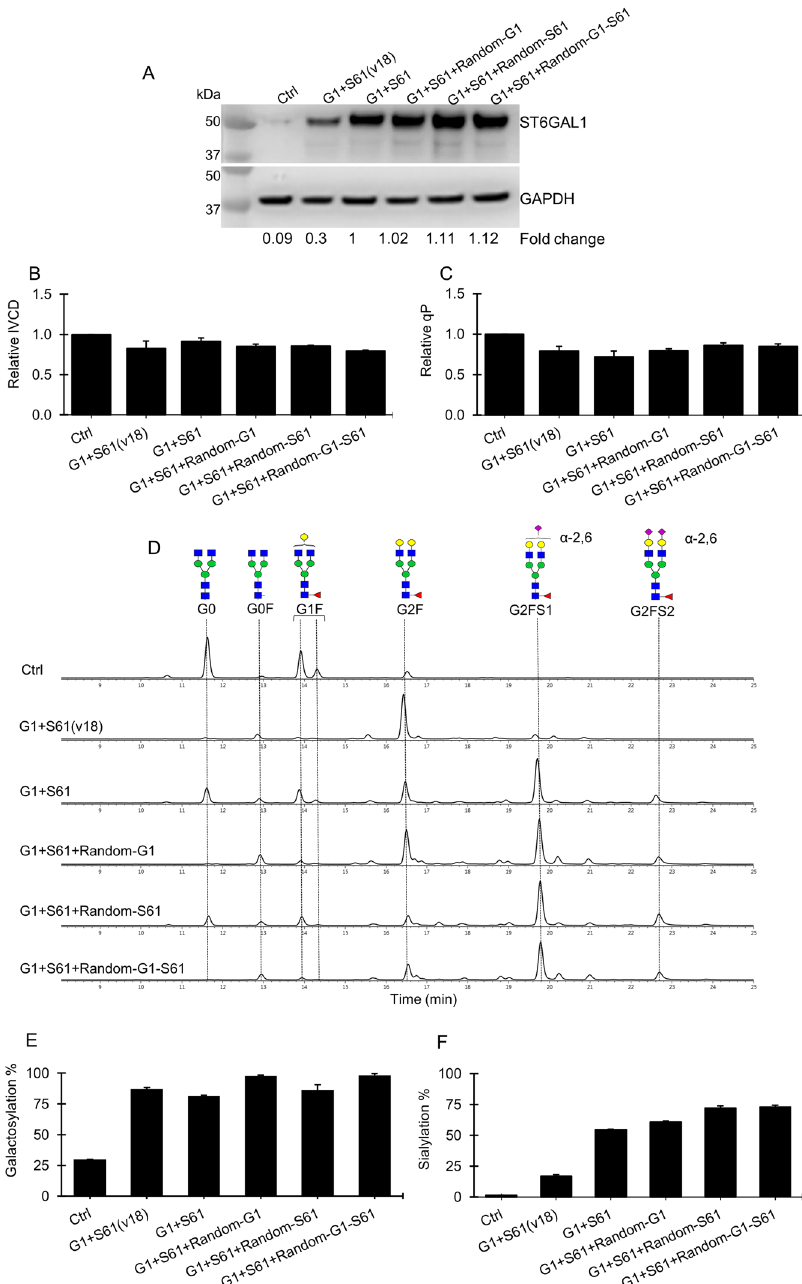
Figure 4. The relationship between the expression level of B4GalT1 and ST6Gal1 and the galactose and sialic acid contents on the antibodies produced in the stably transfected CHO cell pools. The targeted pools of control (Ctrl), G1 + S61 and G1 + S61(v18) were generated using different targeting vectors through RMCE. The control targeting vector expressed IgG rituximab LC, HC and DsRed genes. The two targeted vectors for generating G1 + S61 and G1 + S61(v18) pools were the same, which carried IgG rituximab LC and HC genes, DsRed, B4GalT1 and ST6Gal1, except that the ST6Gal1 in the former vector was controlled by a wild-type IRES while in the latter vector was controlled by a mutant IRESv18 with reduced translation efficiency. The G1 + S61 targeted pools were further transfected with three plasmid vectors expressing B4GalT1 and ST6Gal1 individually or in combination, respectively, followed by selection with blasticidin to generate three sets of stably transfected pools, G1 + S61 + Random-G1, G1 + S61 + Random-S61 and G1 + S61 + Random-G1-S61, for further enhancing B4GalT1 and/or ST6Gal1 expression levels. All stable pools were characterized for growth, productivity and antibody glycosylation in 7-day fed-batch cultures. ( A ) Western Blot analysis of ST6Gal1 protein levels in different stable pools. The housekeeping protein GAPDH was used as a loading control. ( B – C ) Relative change in the integrated viable cell density (IVCD) and specific productivity (qP) to the control pool. ( D ) Aligned HILIC chromatograms of N-glycans on antibodies produced in different stable pools. Chromatograms shown are one of biological replicates with similar results. ( E – F ) Relative distribution of galactosylation and sialylation level of N-glycans on antibodies produced in different stable pools. Two stably transfected CHO cell pools were generated for each vector. Each point represents the average and standard deviation of measurements from two independent stably transfected